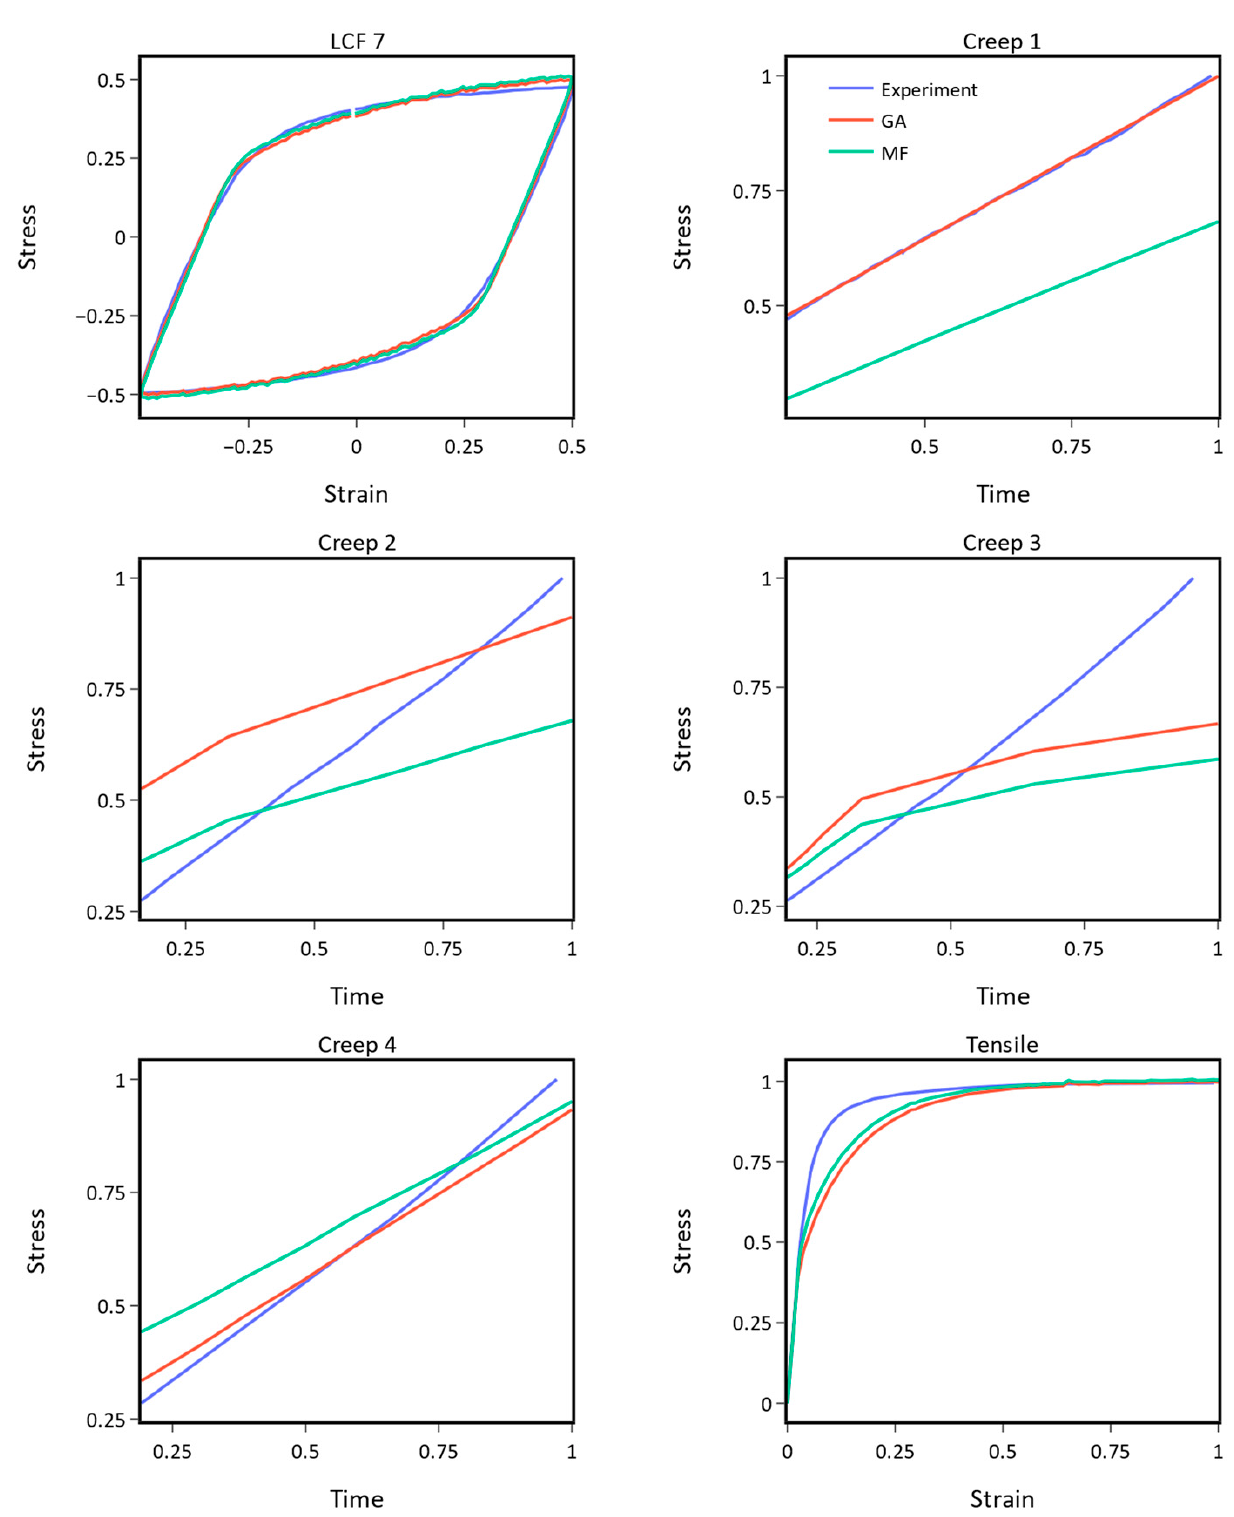
Figure A2. GA and MF methods compared to the experimental curves LCF 7, creep 1–4, and tensile.